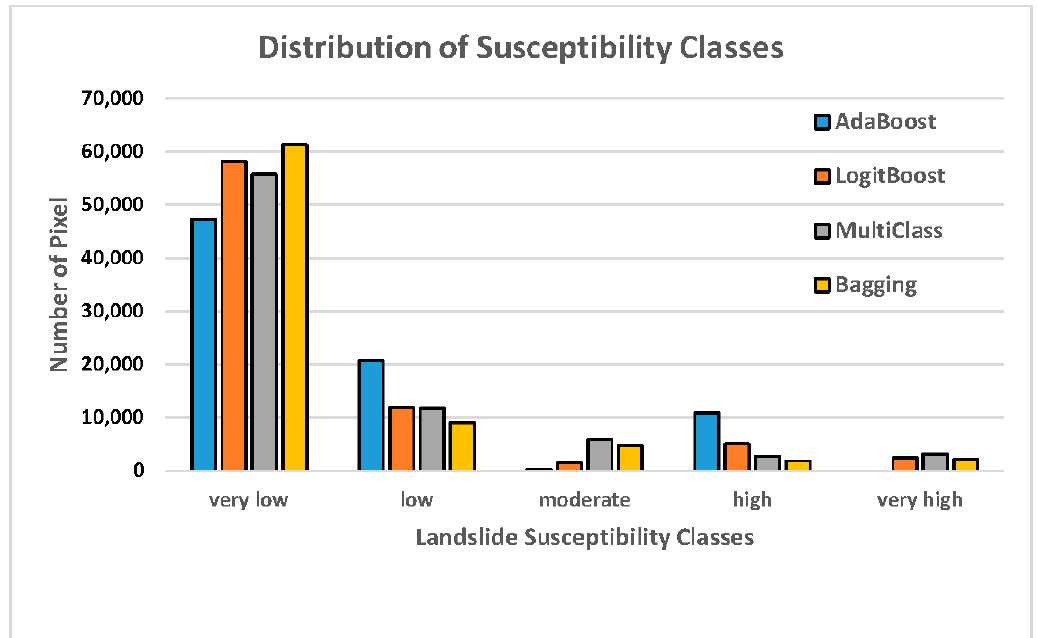
Figure 6. Distribution of susceptibility classes in the landslide susceptibility maps constructed with the four machine learning models.